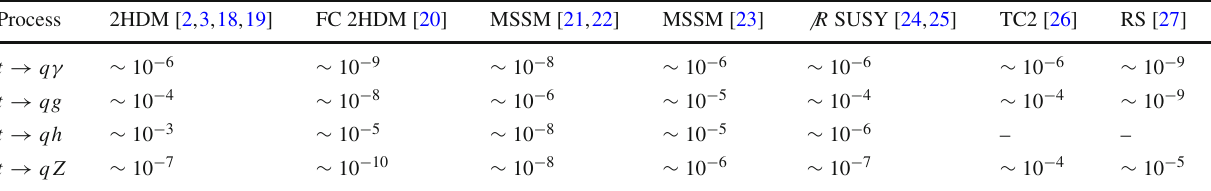
Table 1 FCNC decays branching ratios of several SM extension Process 2HDM [2,3,18,19] FC 2HDM [20] MSSM